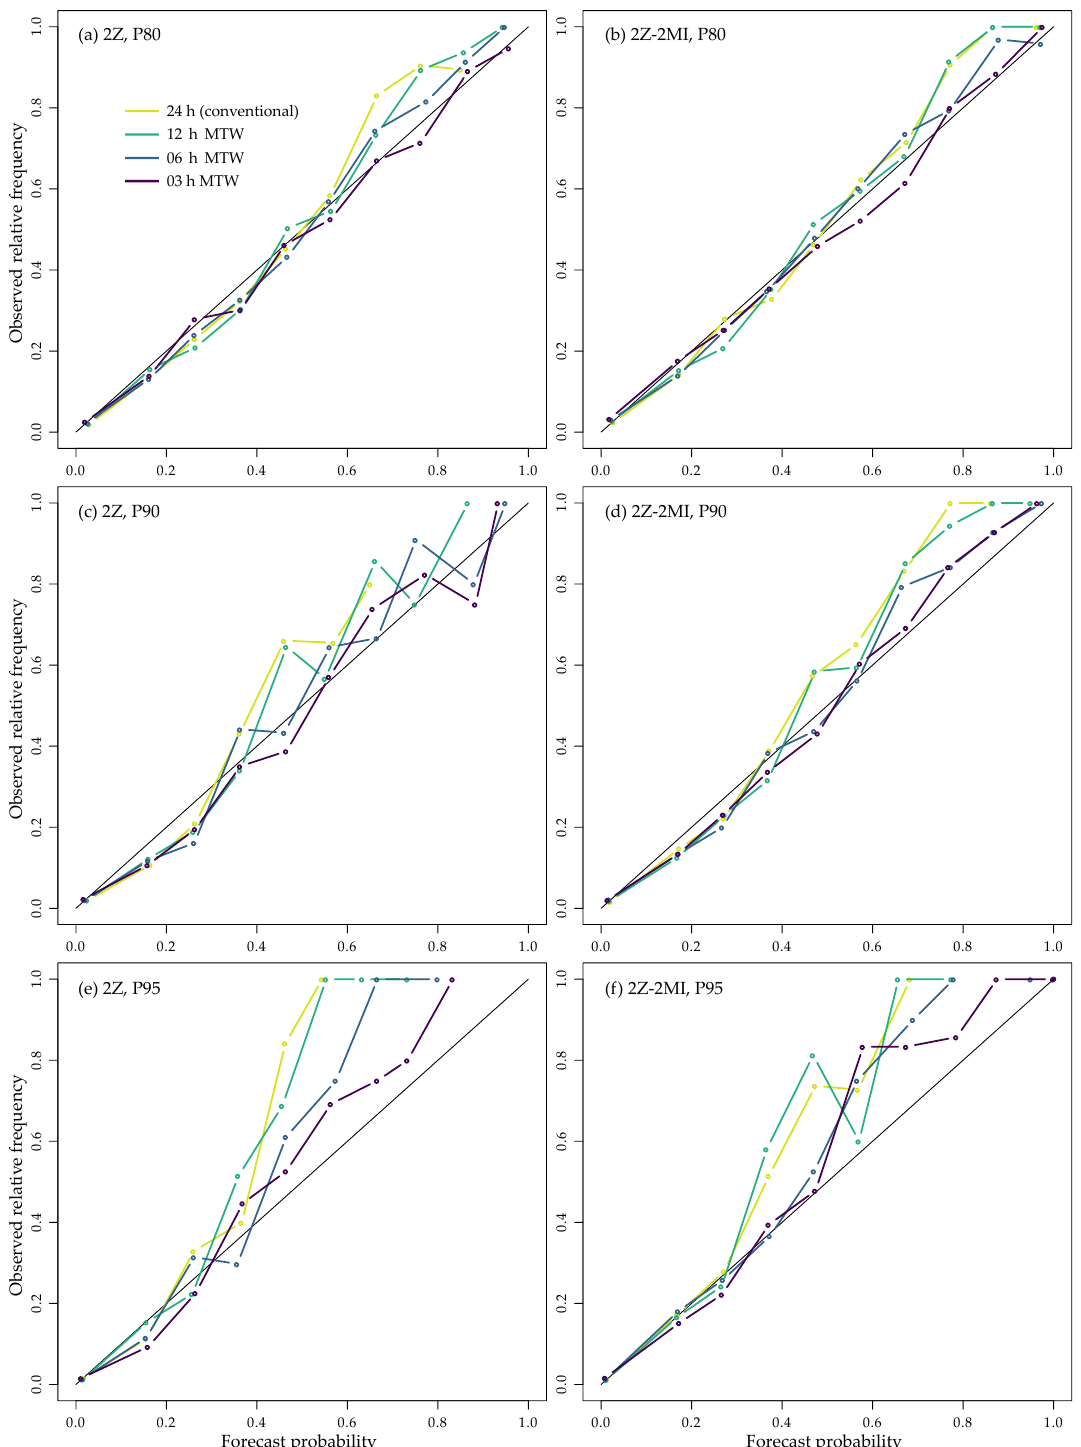
Figure 12. Reliability diagrams for the 2Z (left) and 2Z-2MI (right) methods and the prediction of the exceedance of the 80% (top), 90% (middle), and 95% (bottom) percentiles at the Ulrichen station for the VP. The conventional approach of 24h is provided as well as the 12, 6, and 3h